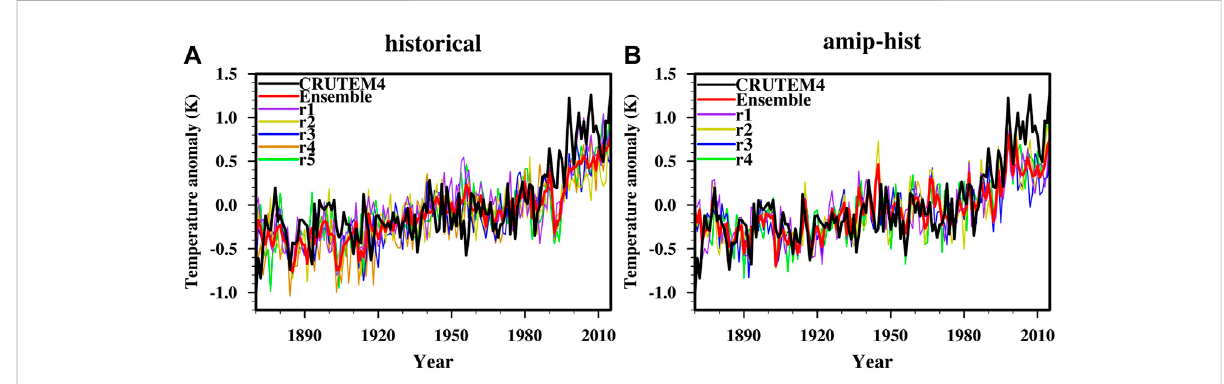
FIGURE 2 Same as Figure 1, but for the (A) coupled model and (B) uncoupled simulations from 1870 to 2014 (units: K; relative to 1961 – 1990 mean). Black line: CRUTEM4; red line: ensemble mean; other colors: the individual model members.